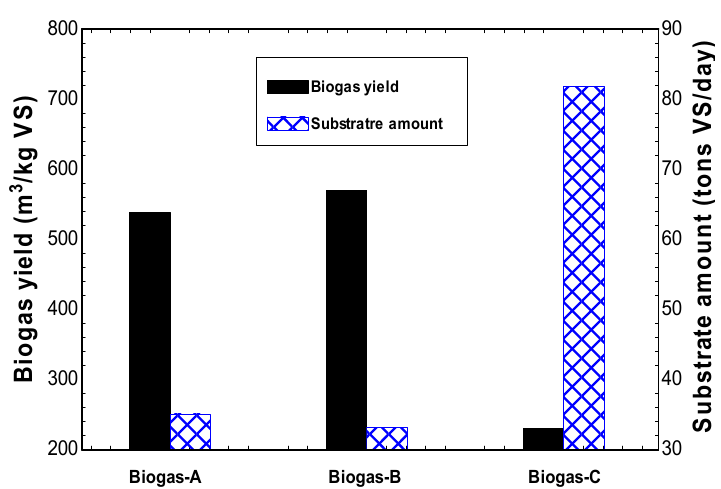
Figure 2. Substrate amount (Tons-VS/day) required for biogas supply to the CHP system.